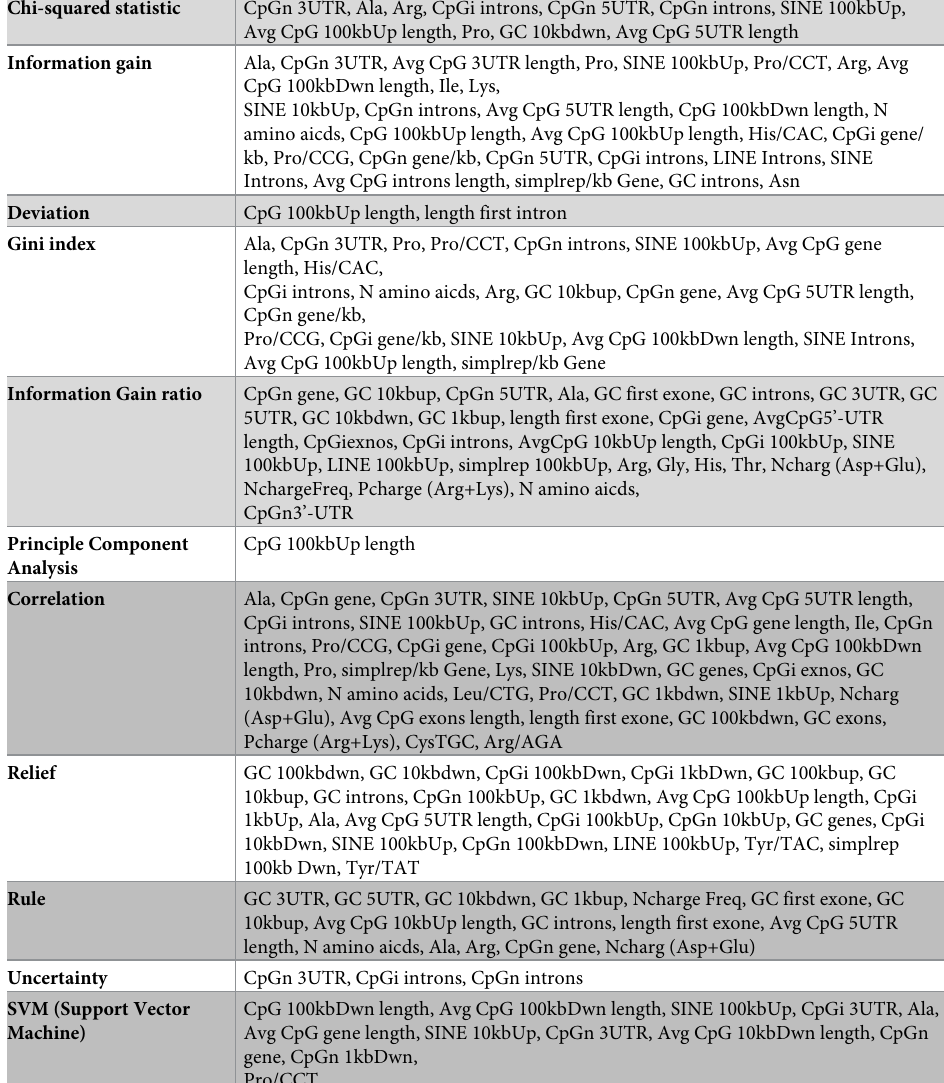
Table 1. Attributes selected by different algorithms of attribute weightings.